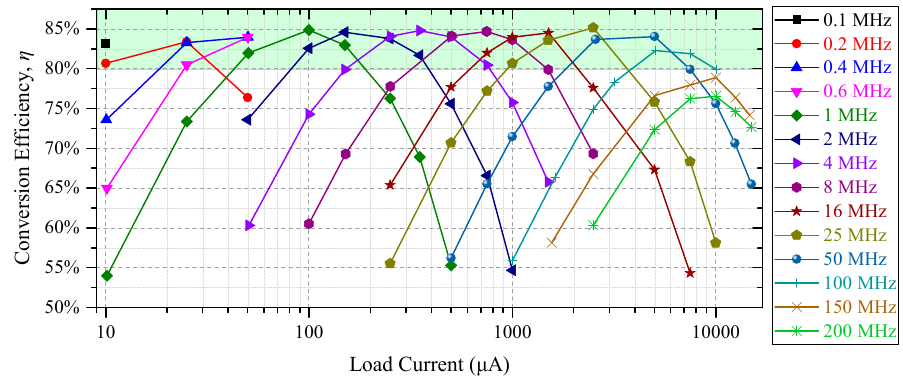
Figure 11. Measurement results demonstrating wide load range performance over various switching frequencies for a voltage conversion ratio of 3/4.